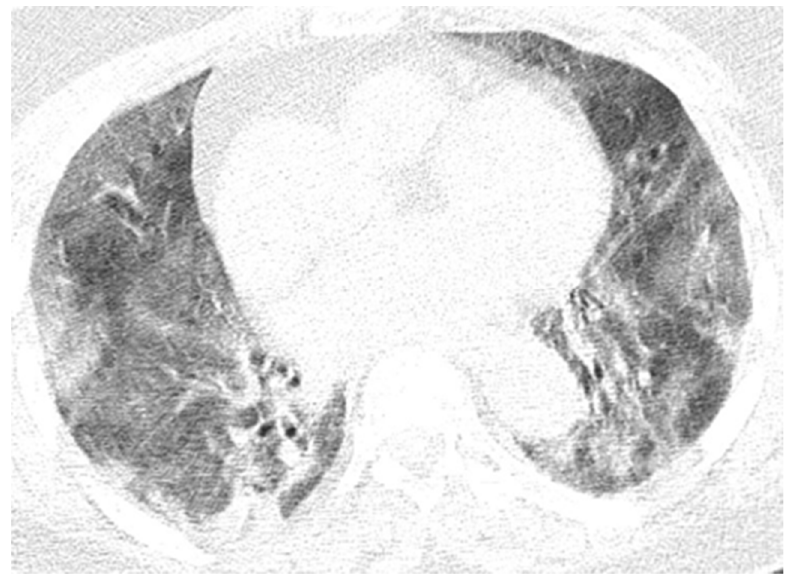
Figure 12. Four days later, pulmonary CT in the Case 10 patient showed dimensional extension of the previously described lesions, with a tendency of small-holding. In conclusion, pulmonary lesions of SARS-CoV-2 type (with the tendency of consolidation) in dimensional progression, with a severity score = 22 (20 for the previous examination), which corresponds to a severe disorder.